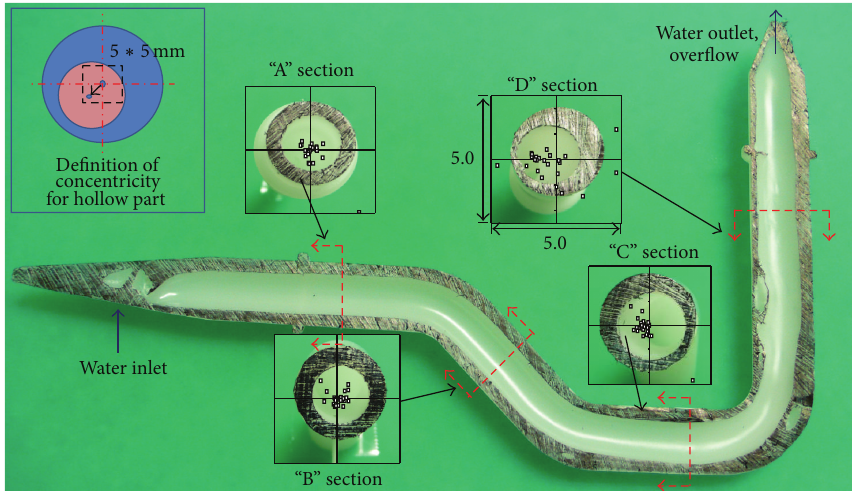
Figure 7: Distribution of residual wall thickness and the concentricity of hollow section at measurement locations (A ∼ D).